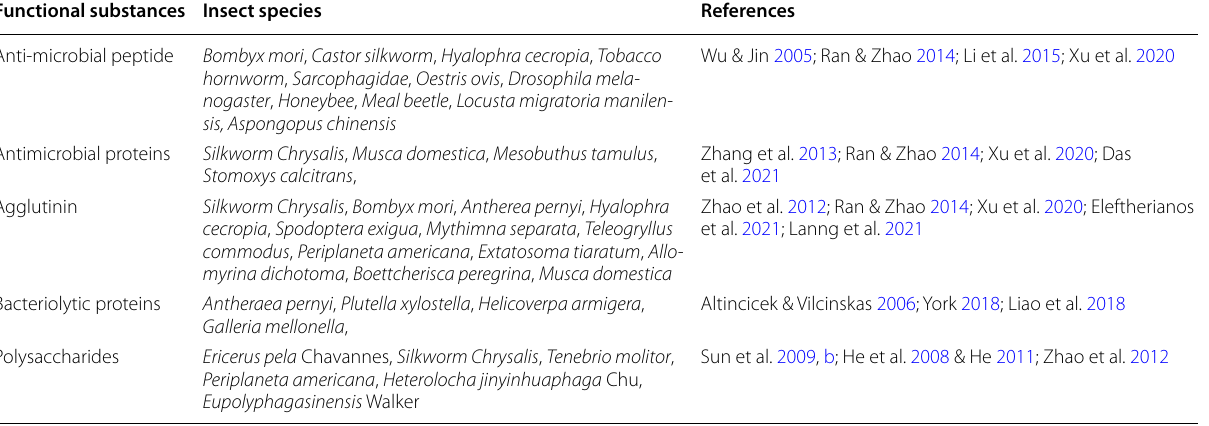
Table 1 The functional substances of immunological regulation in edible insects Functional substances Insect